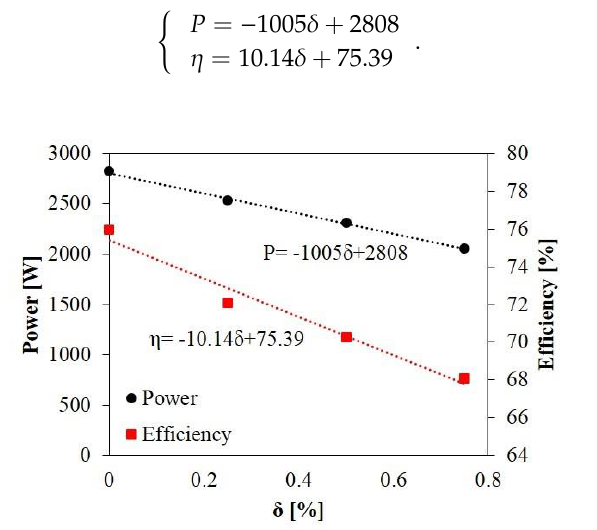
Figure 11. Relationship between power, e ffi ciency, and tip-clearance size in design conditions.